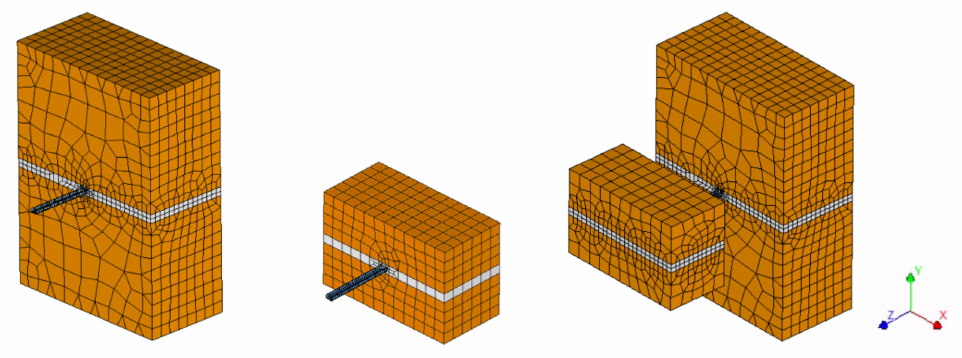
Figure 8. Three numerical models prepared to simulate the experimental